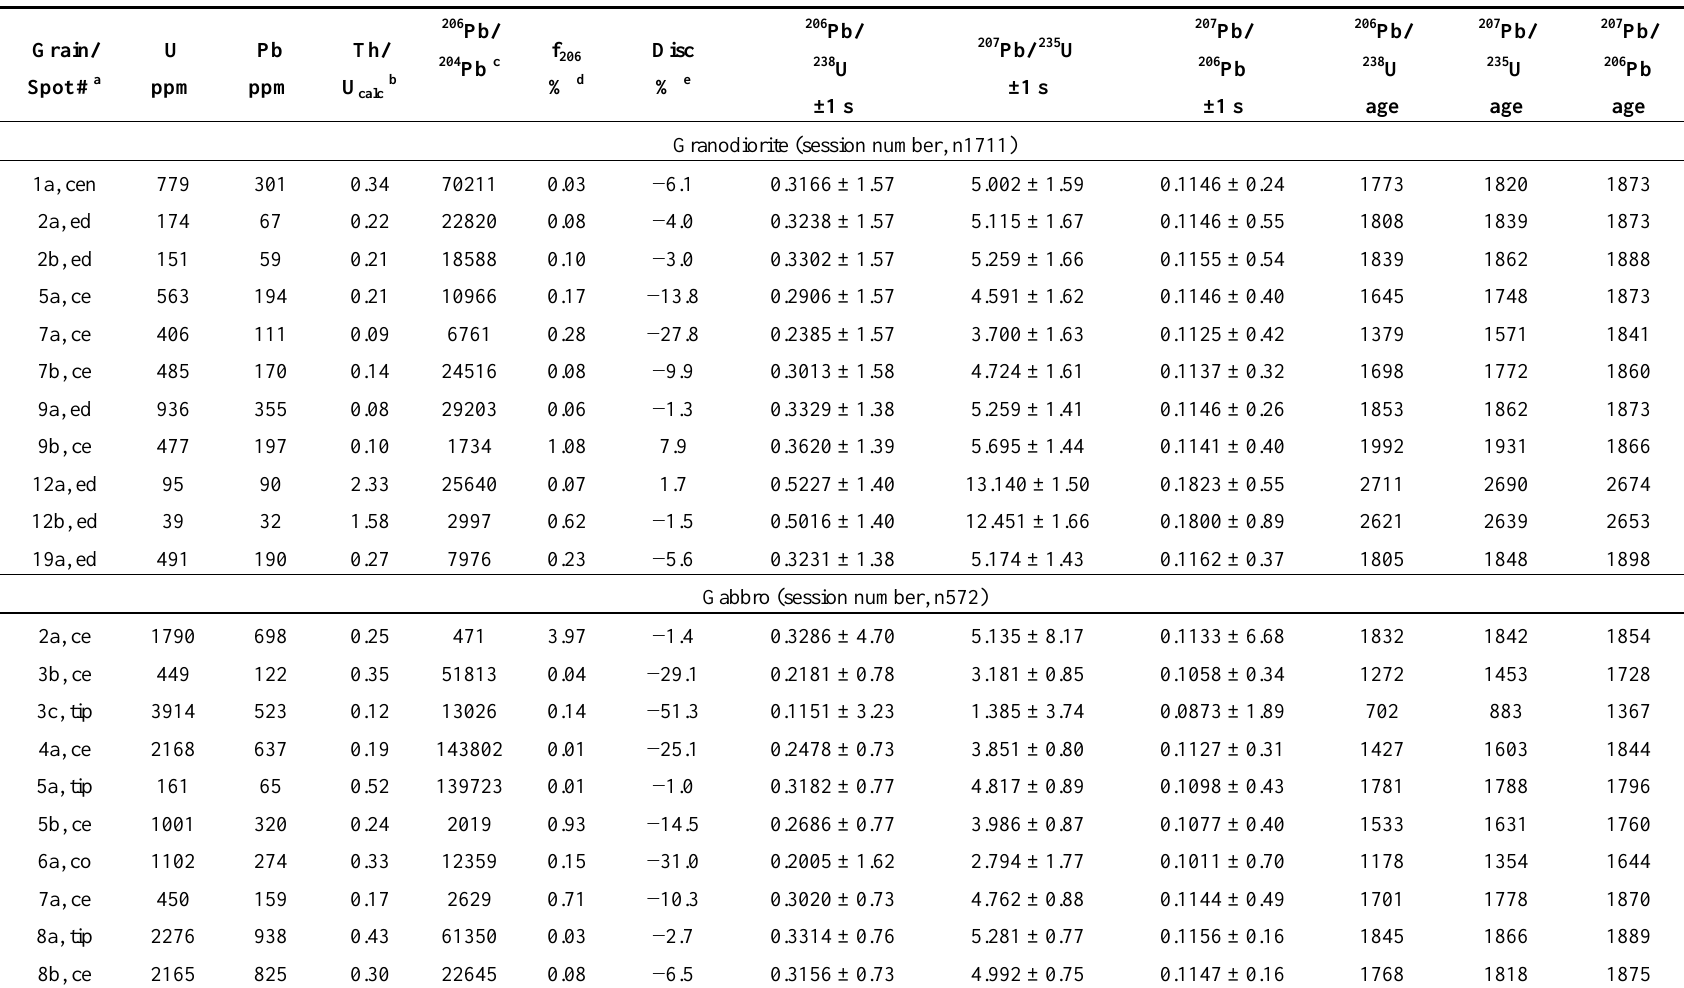
Table 1. Ion microprobe (SIMS) U-Th-Pb isotope data of zircons from a gabbro (96016) and a granodiorite (94002) at